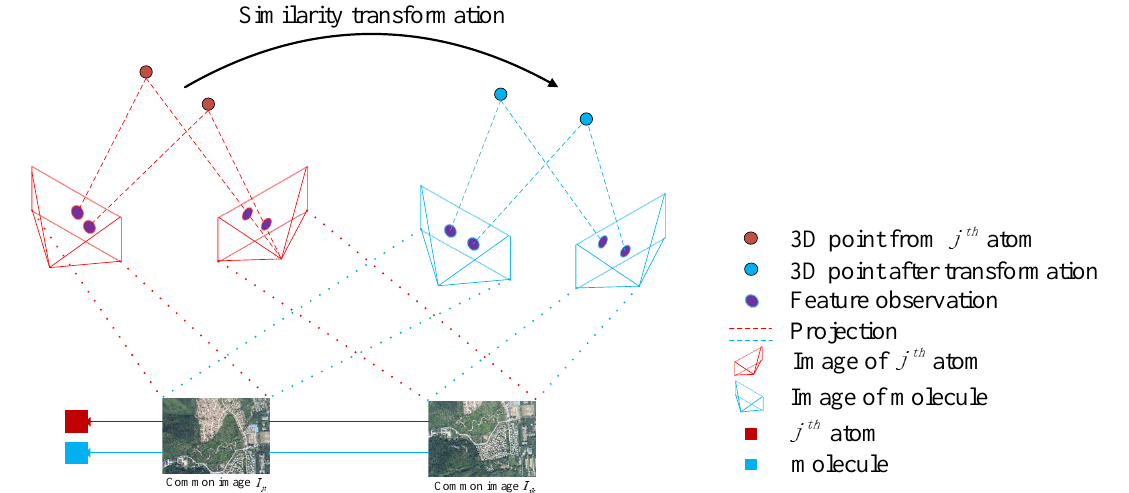
Figure 4. An illustration of the similarity transformation-based BA local optimization. The optimization process contains two steps. In the first step, 3D points from the frame of the j th atom are first transformed into the frame of the molecule by means of similarity transformation. In the second step, the transformed 3D points are projected into the 2D image plane according to the camera poses of common images in the frame of the molecule. With the change in similarity transformation, the projection positions change as well. When the re-projection error is minimum, the optimal similarity transformation is obtained.